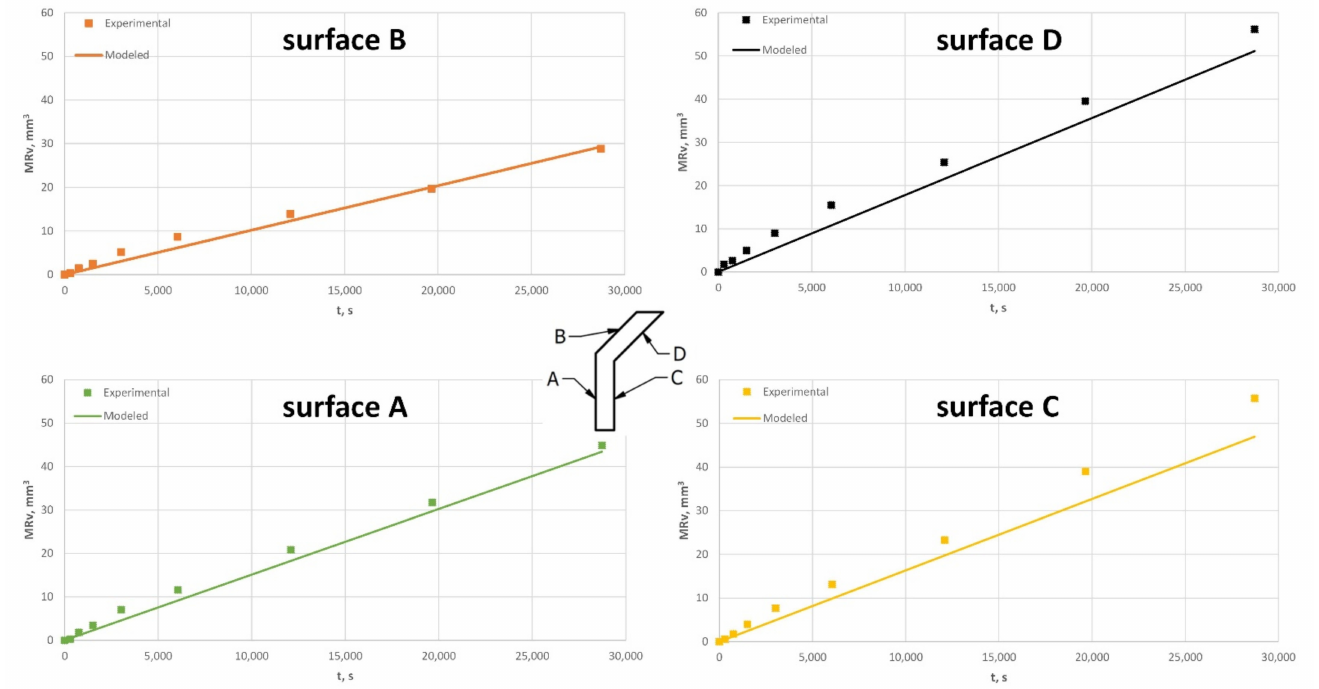
Figure 16. Pre-polished V-shape artifact: MR exp vs. MR model comparison for surfaces B, D, A and C (average